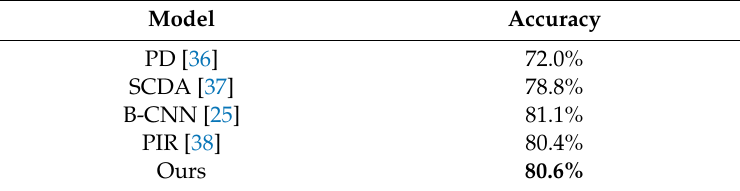
Table 3. Classification accuracy on the Stanford Dogs dataset.